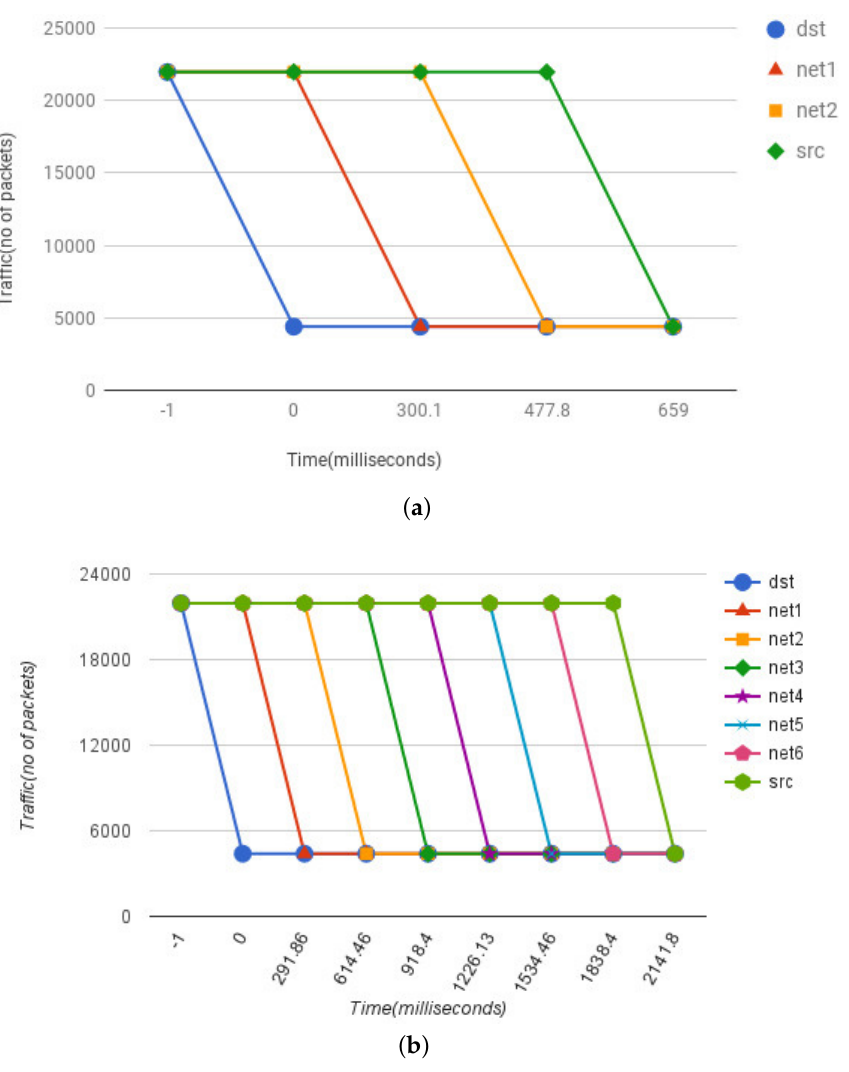
Figure 8. Mitigation Effect in ISP Setting: Shows the effect of mitigation transferred from destination to the source in real ISP settings with AS-AS Latency and Processing Delays. ( a ) Two Intermediate Networks; ( b ) Six Intermediate